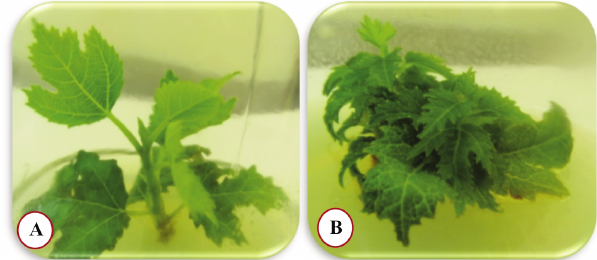
Fig. 1 - Effect of NAA and Kn on nodal explant proliferation in ‘Dehdez’, A= control, B= 0.2 mg l -1 NAA and 6 mg l -1 Kn, 8 weeks after culture.